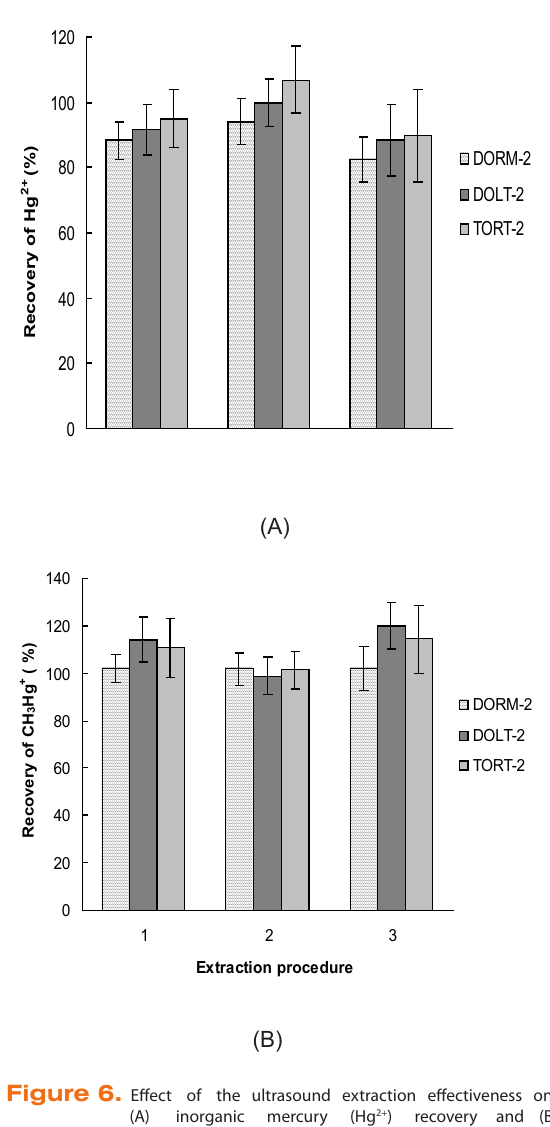
Figure 6. Effect of the ultrasound extraction effectiveness on: (A) inorganic mercury (Hg 2+ ) recovery and (B) methylmercury (CH Hg + ) recovery when different 3 extraction solvents are used: 1- HCl, 2- HCOOH, 3- TMAH. The samples were sonicated for 5 min at room temperature with power 35 W for HCl and 50 W for HCOOH and TMAH. The uncertainty represents the standard deviation of three replicates.